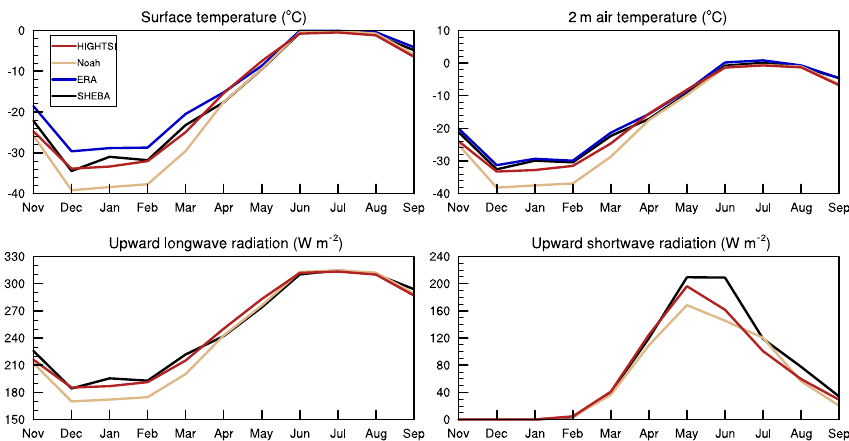
Figure 4. Monthly mean surface temperature, 2m air temperature and surface upward long-wave and shortwave radiation simulated and observed at the SHEBA